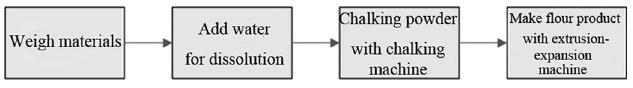
Fig. 2. Production process of wheat fl our products.